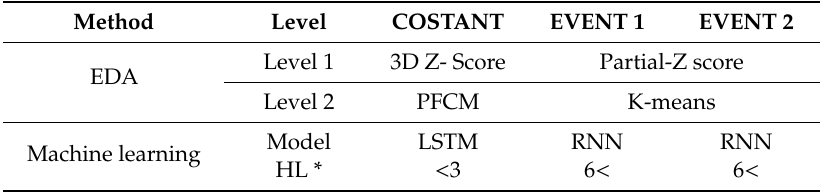
Table 3. Condition for the best performance under each situation.